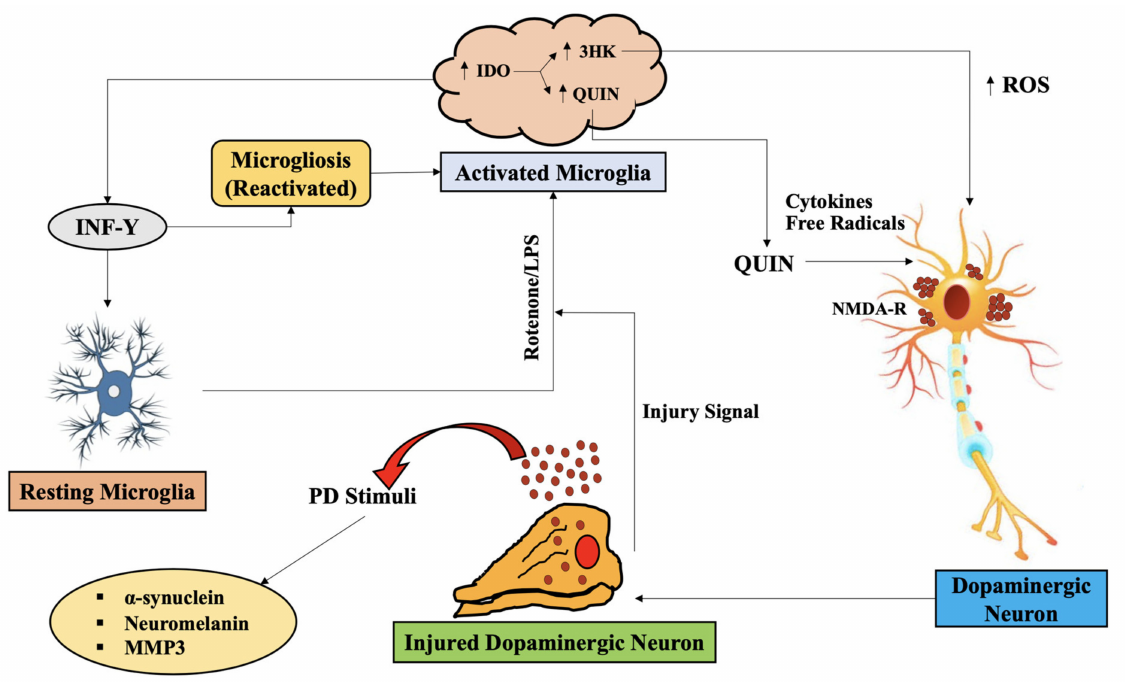
Figure 3. Microglial activation resulting in QUIN-mediated damage to the dopaminergic neuron, leading to PD. Legend: IDO—Indoleamine 2,3-dioxygenase, QUIN—quinolinic acid; NMDAR—NMDA receptor; KYNA—kynurenic acid, INF- γ — interferon-gamma, 3-HK—3-hydroxykynurenine, ROS—reactive oxygen species, PD—Parkinson’s disease, MMP3—matrix metalloproteinase-3., ↑ increased